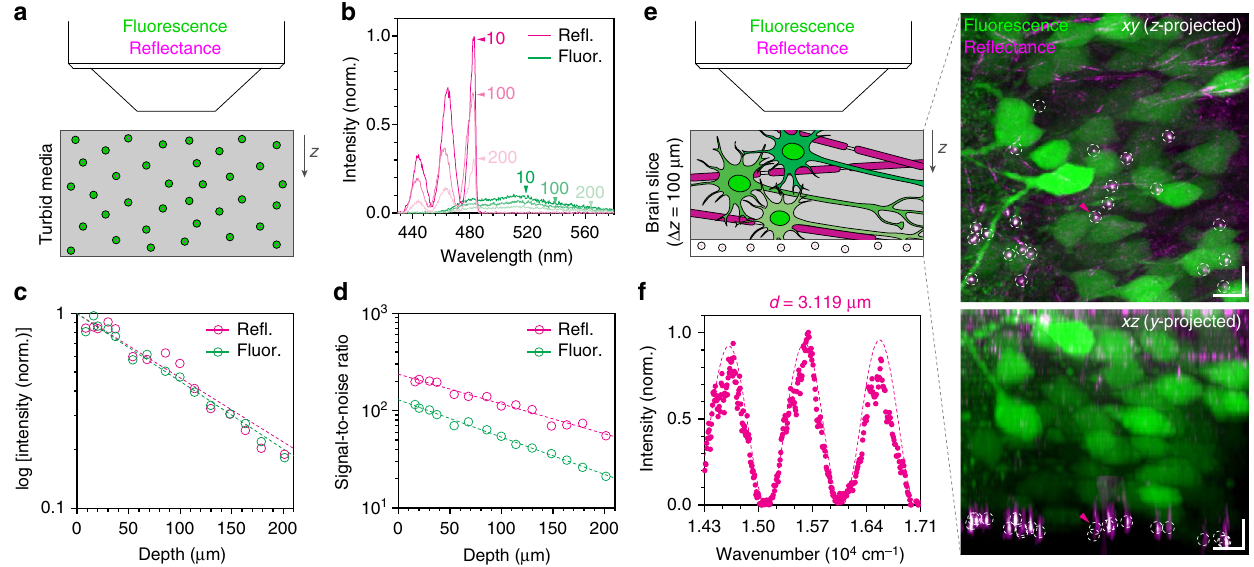
Fig. 4 Re fl ectophore in turbid media. a Setup of phantom study. The phantom was prepared by mixing fl uorescent re fl ectophores ( d ≈ 3 μ m and 8 μ m) in a scattering medium (alumina 0.2% (w/w) in PDMS). b Representative re fl ectance (magenta) and fl uorescence (green) spectra for re fl ectophores in the scattering media. The numbers with arrowheads indicate depths in μ m. c Quanti fi cation of attenuation length. Dashed lines indicate the best- fi t to the exponential decay ( R 2 : 0.94 for “ Re fl . ” and 0.96 for “ Fluor. ” ). d Quanti fi cation of signal-to-noise ratio. Dashed lines indicate the best- fi t to the exponential decay ( R 2 : 0.97 for “ Re fl . ” and 0.99 for “ Fluor. ” ). e Re fl ectophore in brain tissue. A brain slice prepared from a Thy1-YFP mouse is overlaid on top of polystyrene-based re fl ectophores ( d ≈ 3 μ m) and imaged by fl uorescence (green) and re fl ectance (magenta) in a z -stack. The fi brous structures in the re fl ectance image are myelinated axons because of their unique multilayered cytoarchitecture. The dotted circle indicates the re fl ectophore at a depth of 100 μ m from the tissue surface. To compensate the depth-dependent signal attenuation, intensity was normalized for each slice. Scale bar, 10 μ m in xz . f Re fl ectance spectrum measured from the re fl ectophore in e . Dotted line is the best- fi t simulated data ( d = 3.119 μ m) to the measured spectrum ( R 2 =